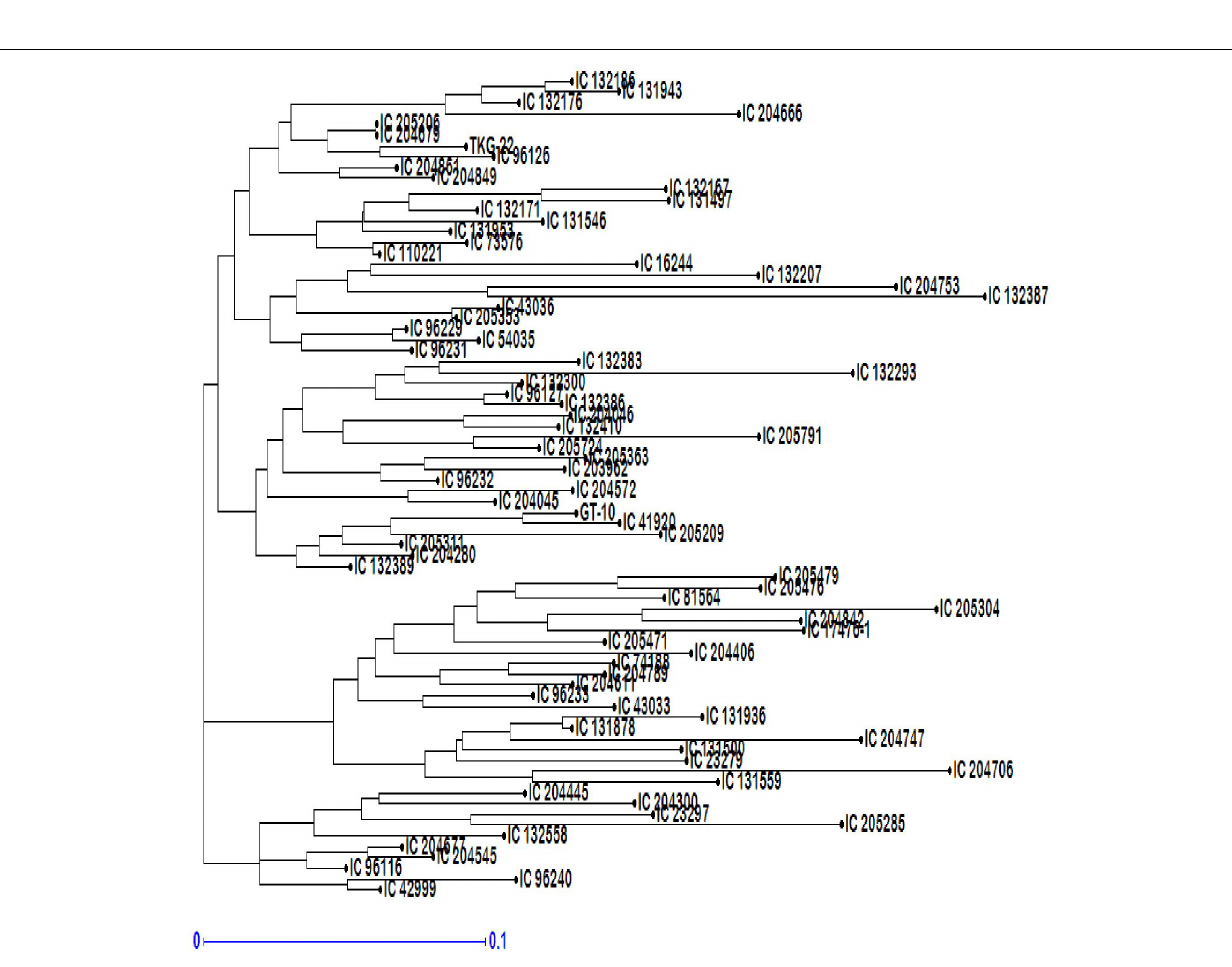
Frontiers in Plant Science |